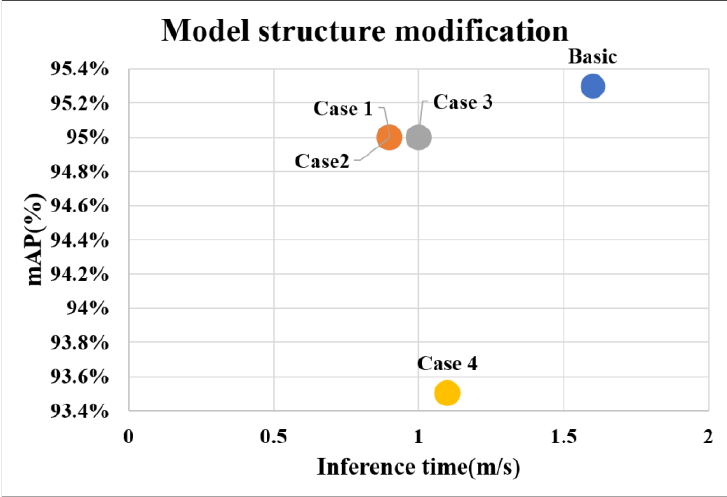
Figure 14. Result graph (structure modification). Table 4. Model scaling.